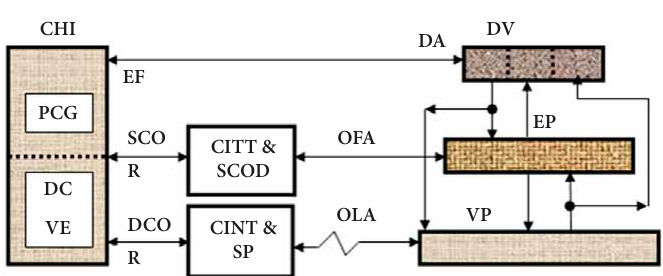
Fig. 2. A cybernetic representation of interactions between CHI, access facilitators and culture consumers Source : adapted from Filip